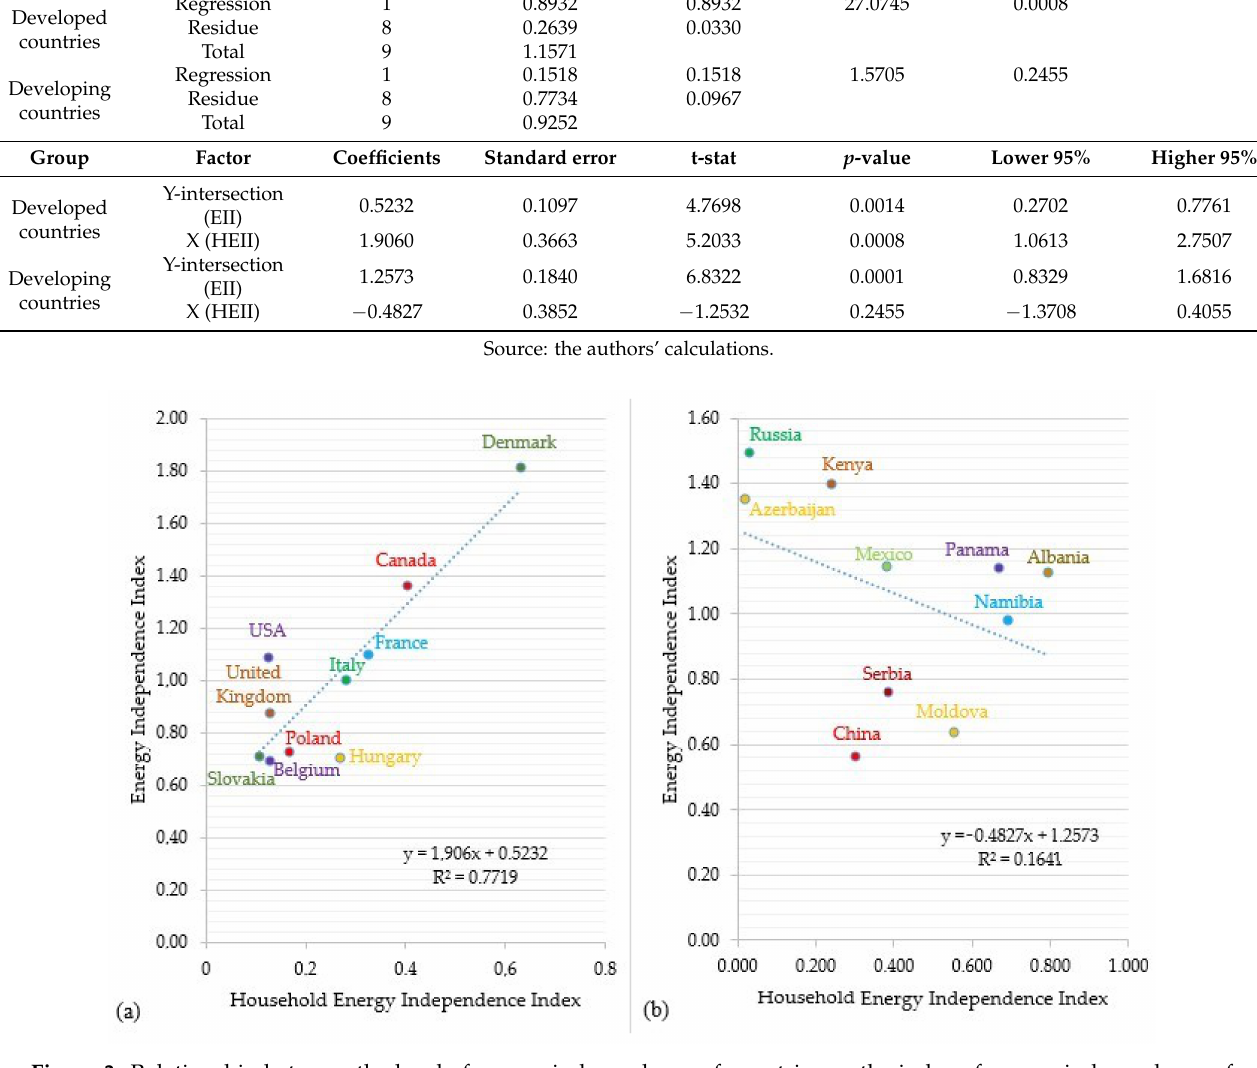
Figure 3. Relationship between the level of energy independence of countries on the index of energy independence of households of the studied developed ( a ) and developing ( b ) countries. Source: generated by the